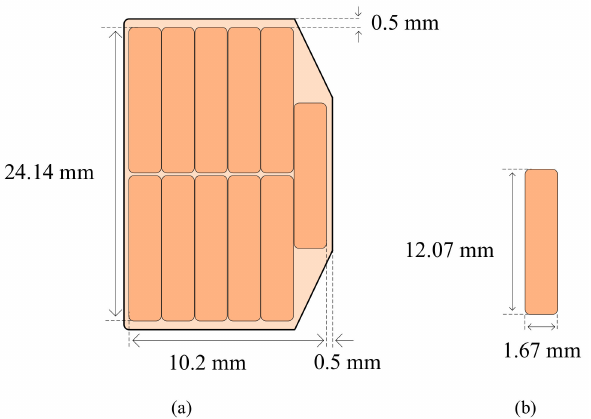
Figure 3. ( a ) The dimension and the arrangement of one turn and ( b ) the dimension of one conductor for LV winding.